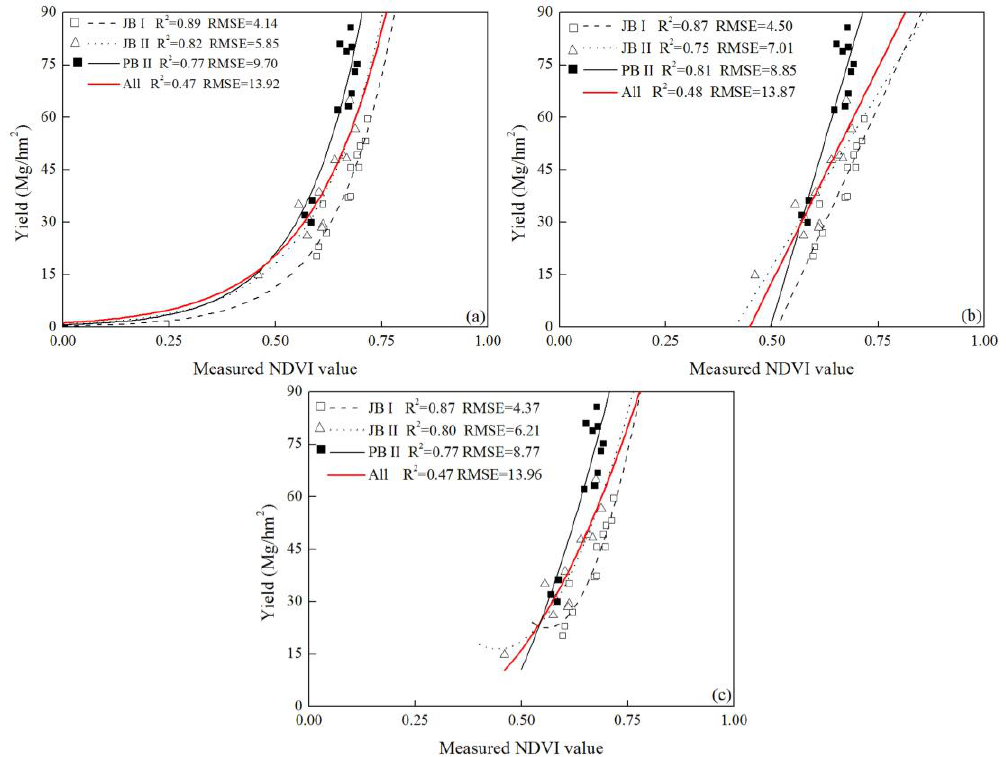
Figure 4. Plots of the relationship between observed cabbage yield and NDVI (normalized difference vegetation index) measurements for all cultivar-years (JB cultivar in year I and II (JB I and JB II) and PB cultivar in year II (PB II)); ( a ) exponential, ( b ) linear and ( c ) quadratic equation).